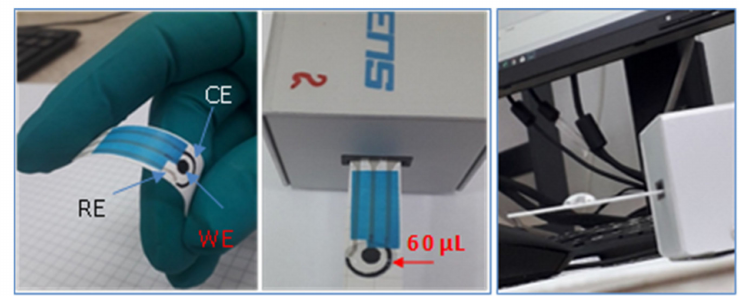
Figure 1. Optical images of the flexible screen-printed